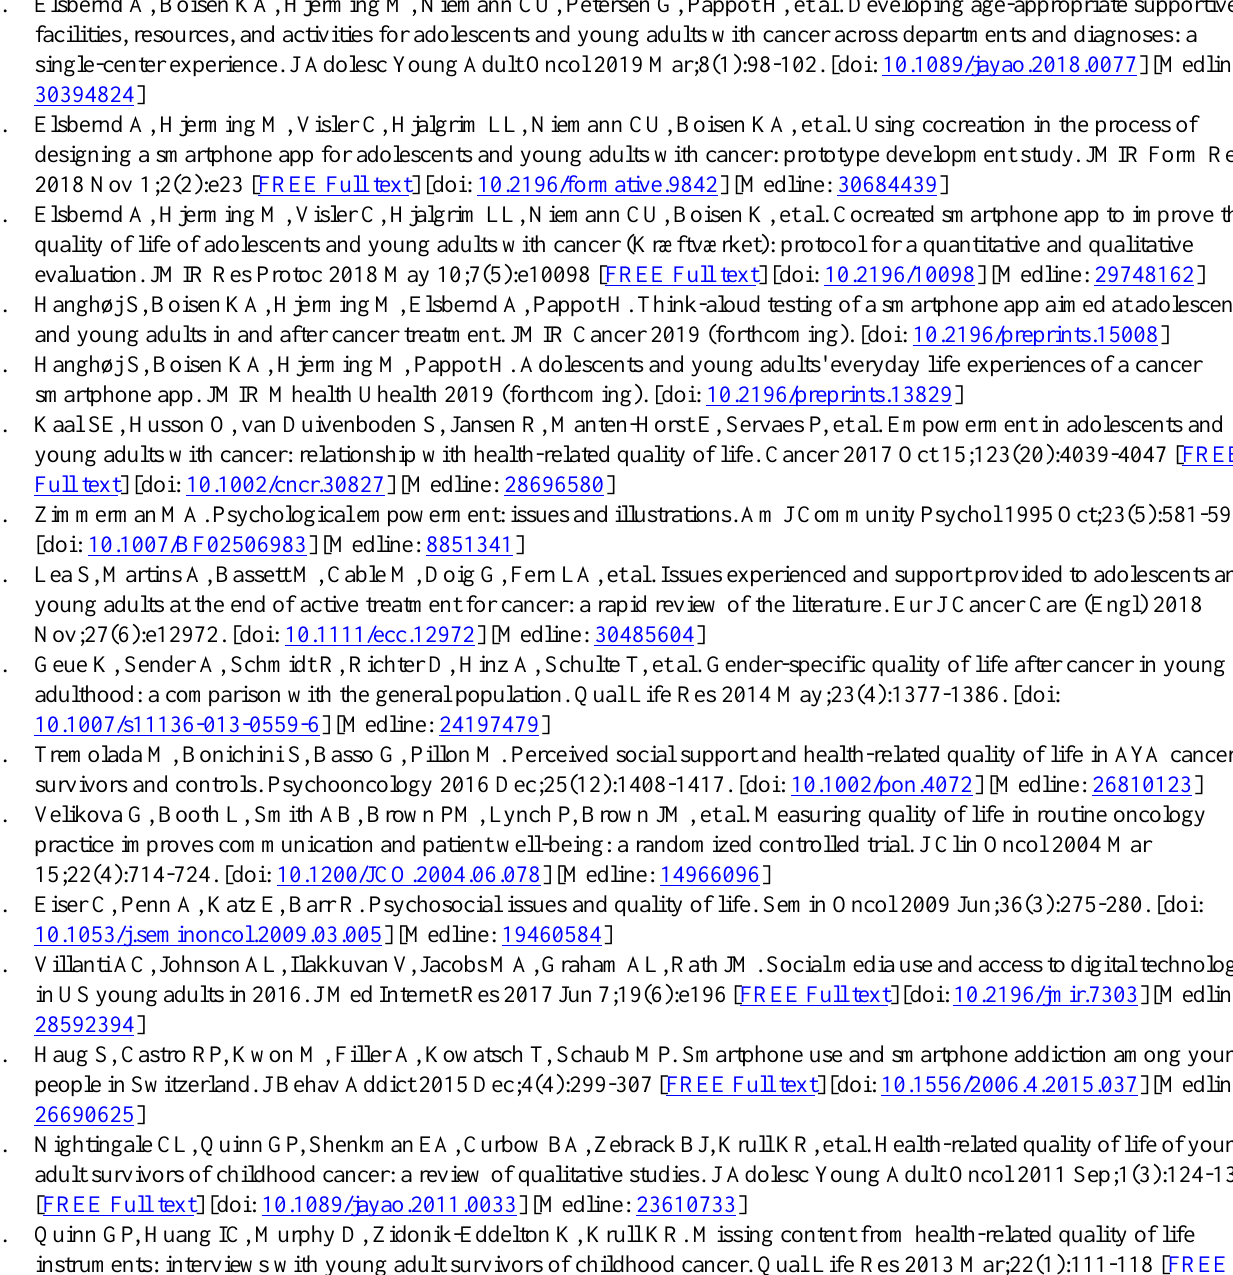
Abbreviations AYA: adolescent and young adult EORTC QLQ-C30: 30-item European Organization for Research and Treatment of Cancer Quality of Life